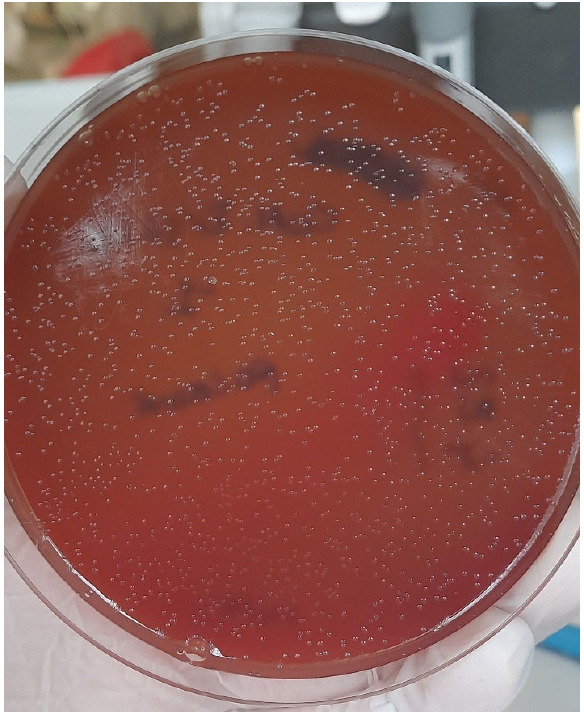
Figure 4. Microbiological findings from conjunctival sample: colonies were grown on blood agar and were identified as Pasteurella multocida.